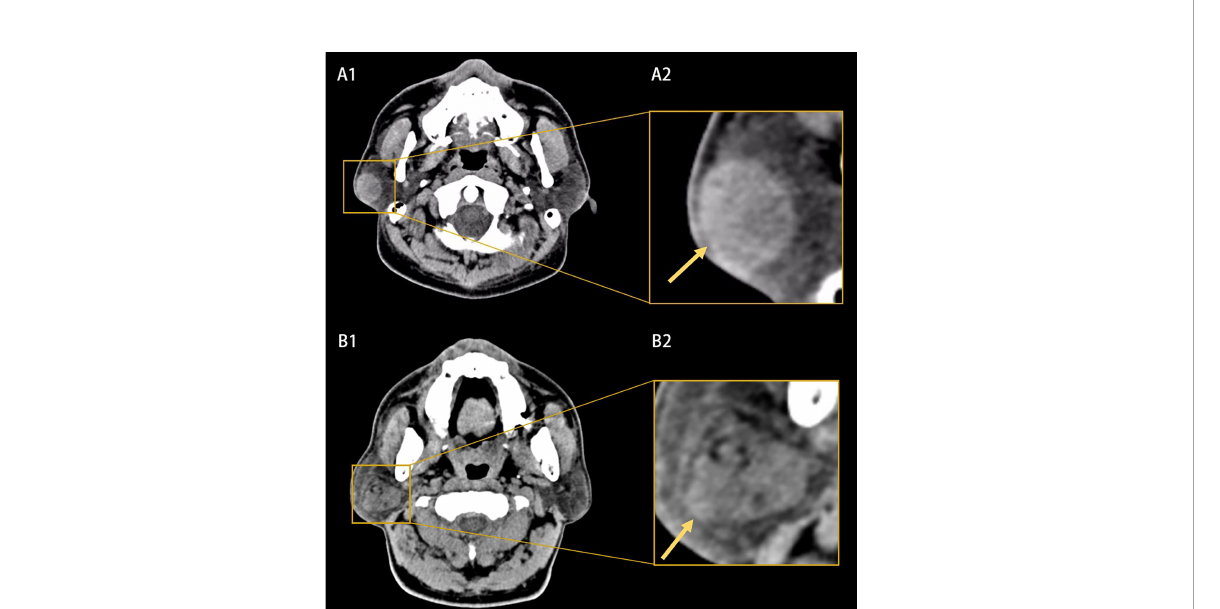
FIGURE 1 Example of computed tomography (CT) images (A1, B1) and the extracted region of interests (A2, B2) . (A1, A2) Showed a benign parotid tumor with a well-de fi ned and smooth border and homogeneous appearance (yellow arrow). (B1, B2) Showed a malignant parotid tumor with a poor- de fi ned border and heterogeneous appearance (yellow arrow).